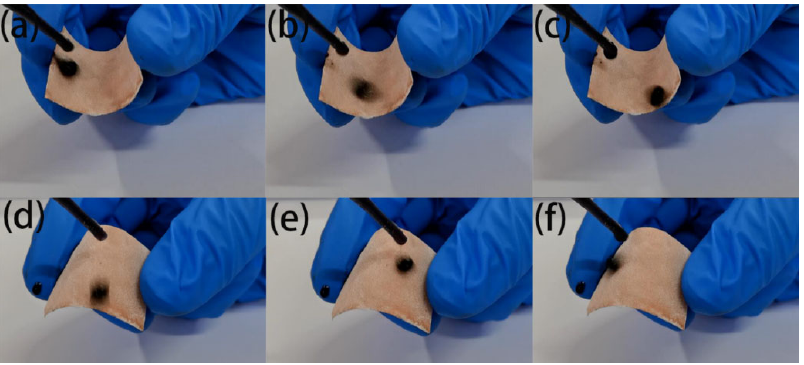
Figure 6. ( a – c ) Water droplets rolling off from the sample surface bent into a concave surface. ( d – f ) Water droplets rolling off from the sample surface bent into a convex surface.